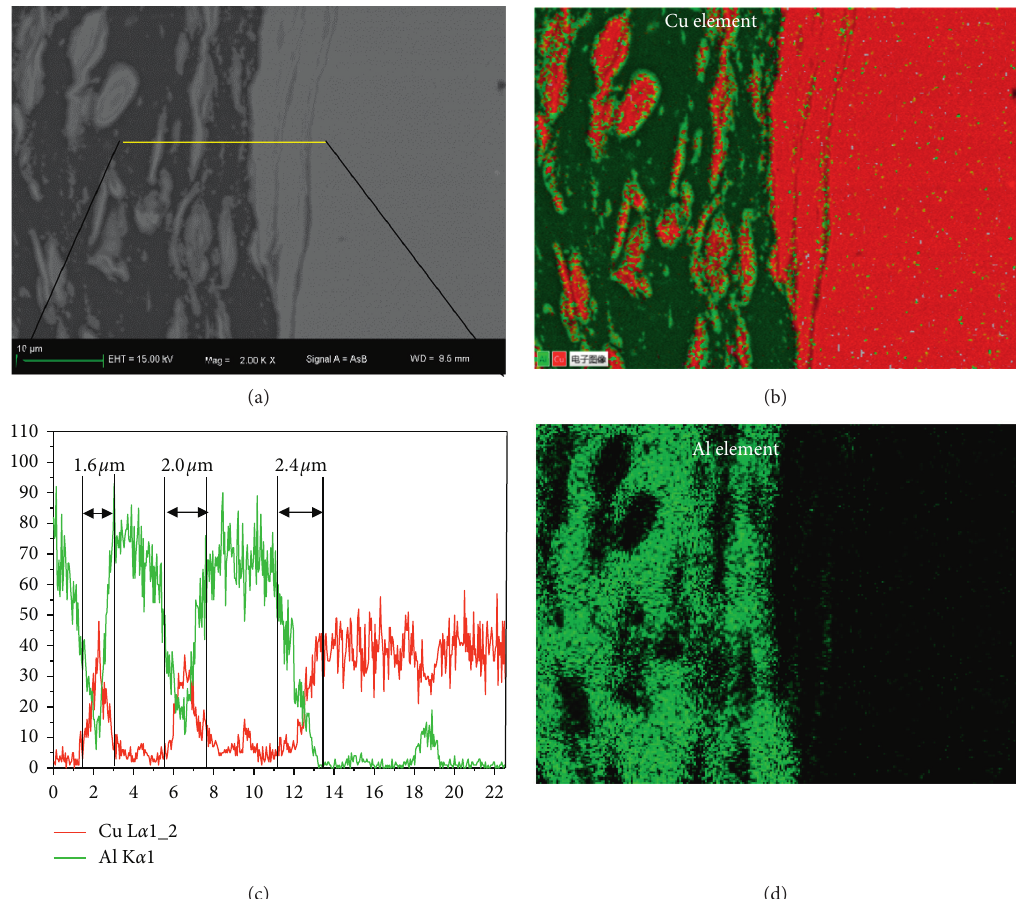
Figure 5: An interlaced structure on the Al-Cu interface: (a) interface feature, (b) Cu element distribution, (c) distribution of elements perpendicular to the interface, and (d) Al element distribution.